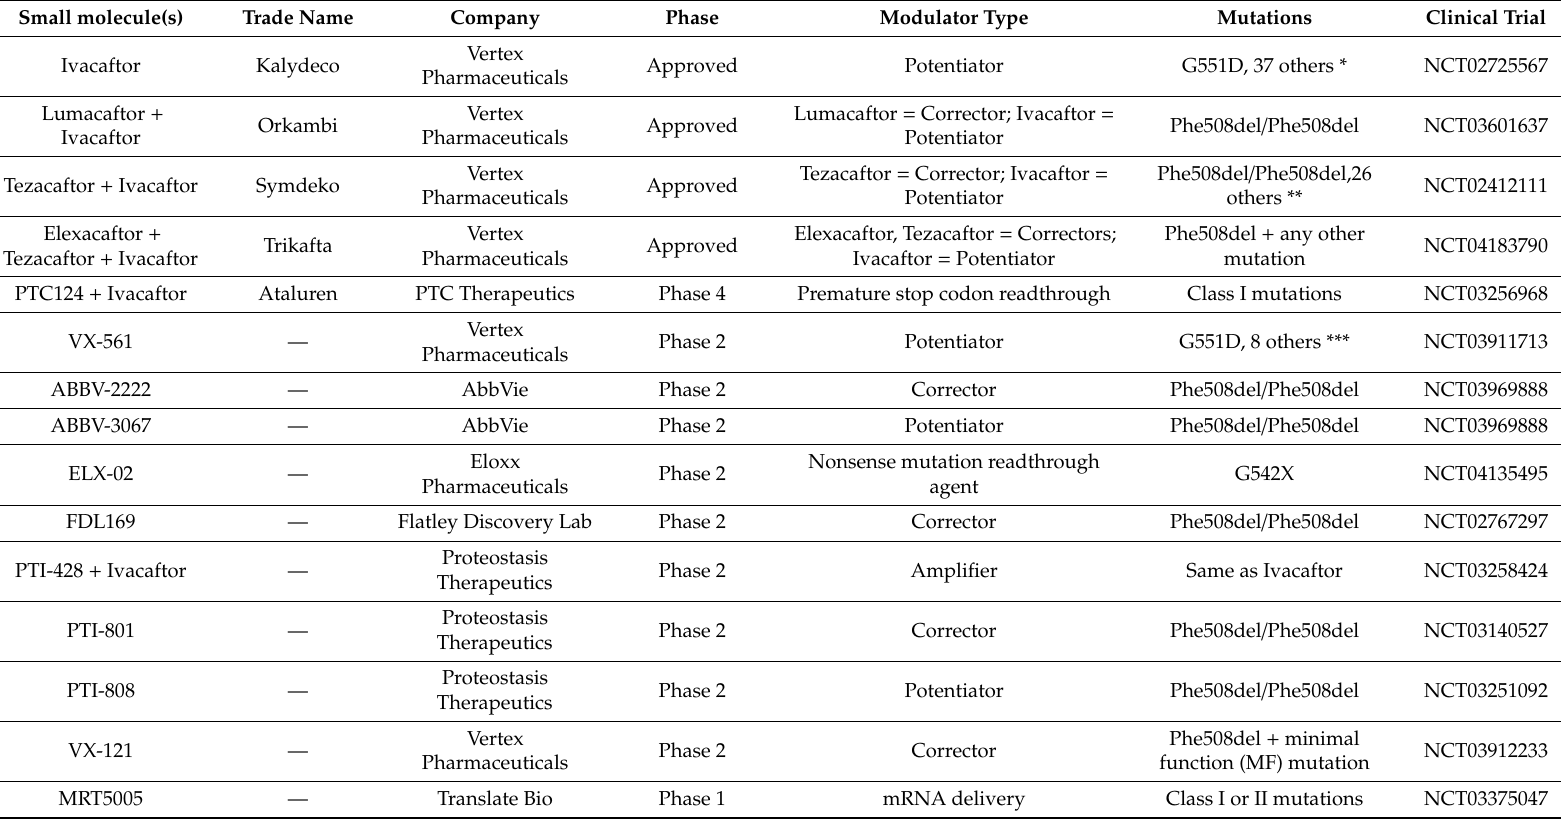
Table 1. Selected clinical trials using small molecule modulators for cystic